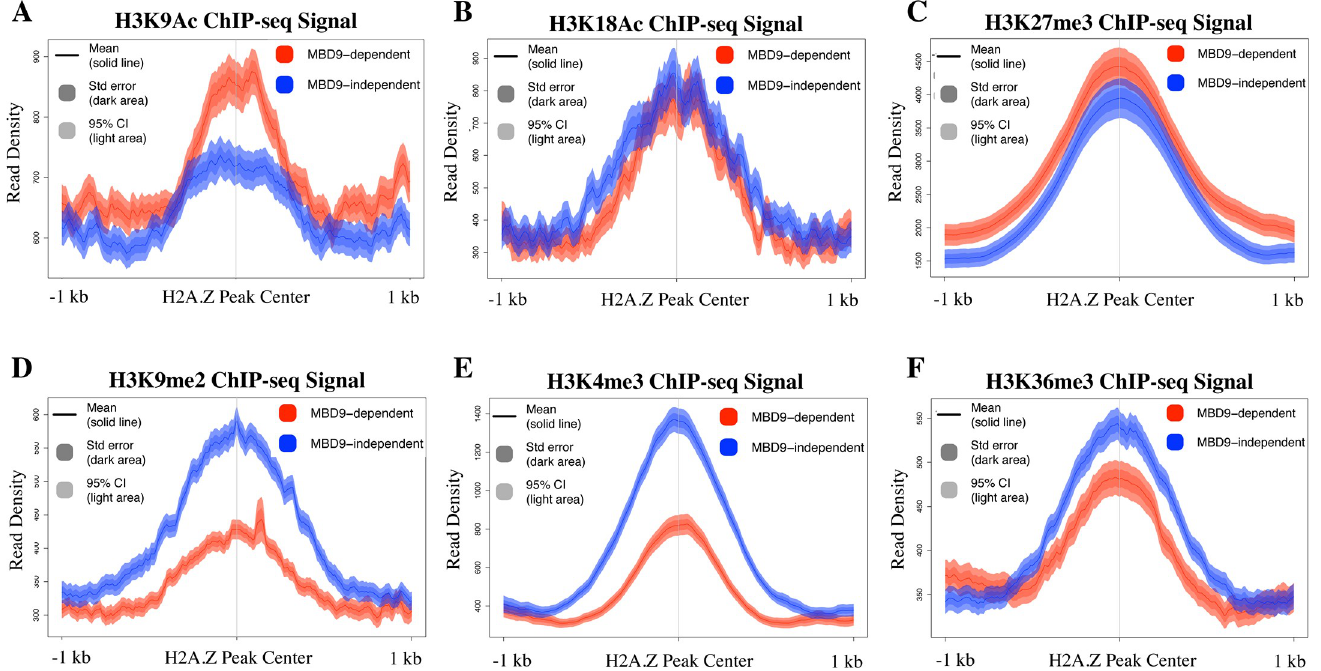
Fig 4. H2A.Z sites that require MBD9 have distinct chromatin properties. Average ChIP-seq profiles of H3K9Ac (A), H3K18Ac (B), H3K27me3 (C), H3K9me2 (D), H3K4me3 (E), and H3K36me3 (F) at MBD9-dependent H2A.Z sites (shown in red) and MBD9-independent H2A.Z sites (shown in blue). Plots show a 2 kb window around the center of the MBD9-dependent and MBD9-independent sites. Average read density for either set of sites is shown as a single line depicting the mean with standard error denoted as dark shading, and 95% confidence interval denoted as light shading.